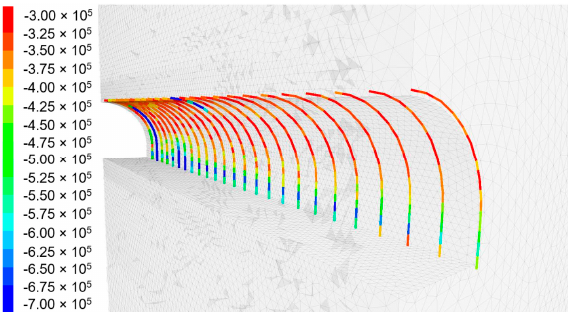
Figure 13. Axial forces in the modelled supports, expressed in newtons, variant 0.